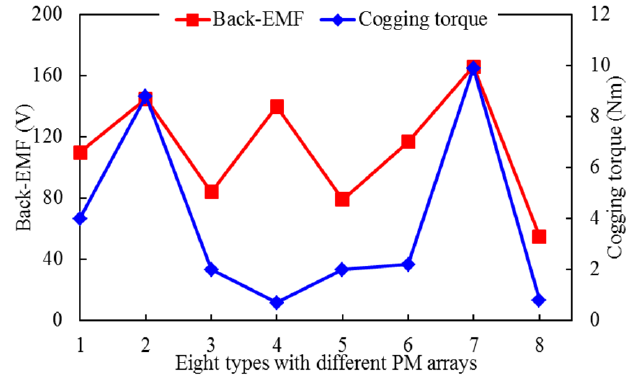
Figure 7. Back-EMF and cogging torque of eight types.